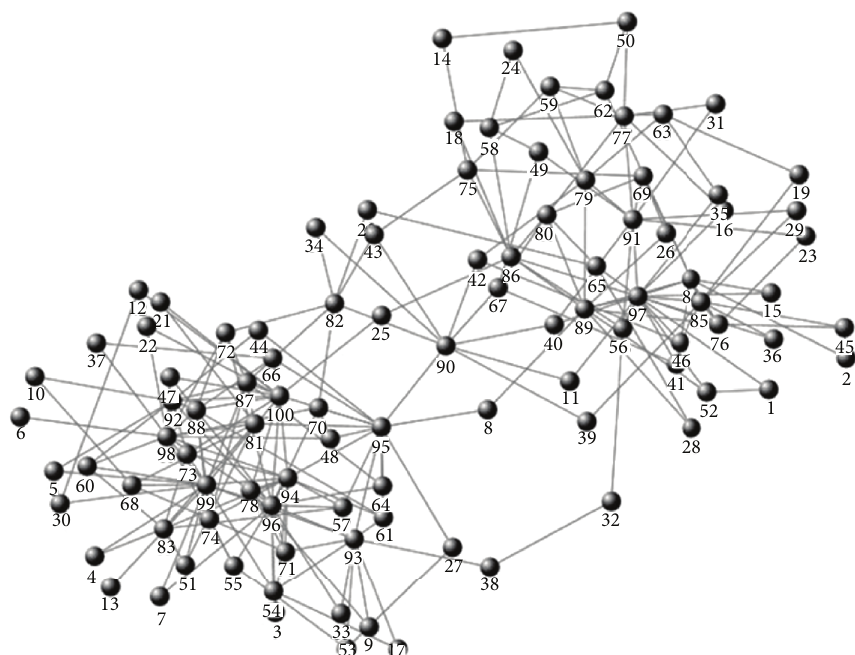
Figure 2: Artificial complex network.